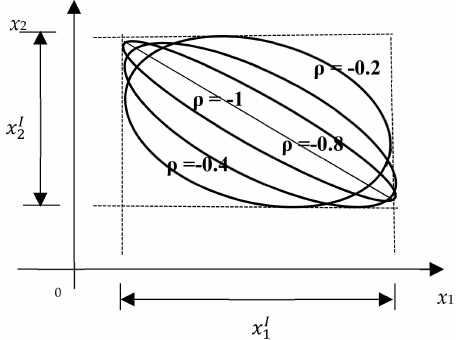
Figure 5. Two-dimensional ellipsoidal uncertainty domain of negative interaction coe ffi